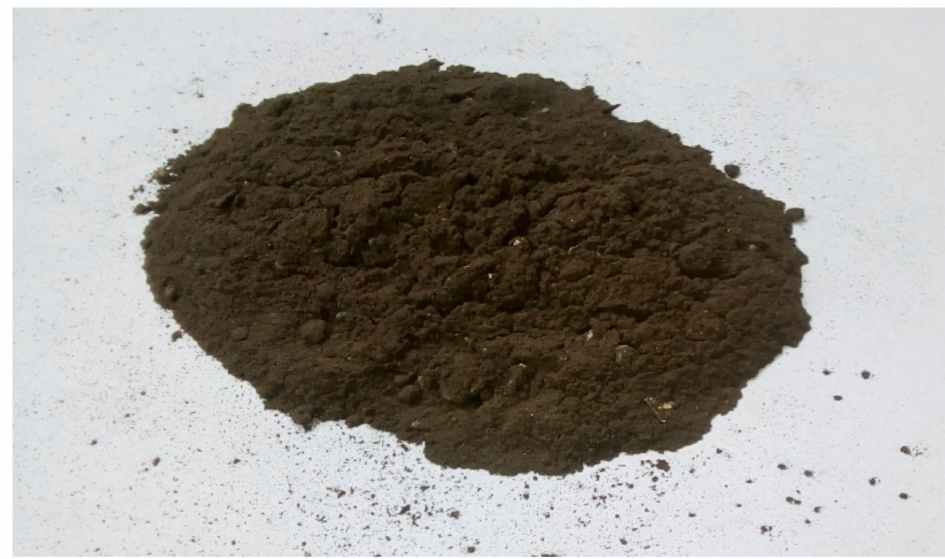
Figure 4. Raw bagasse ash (BA) collected from sugar